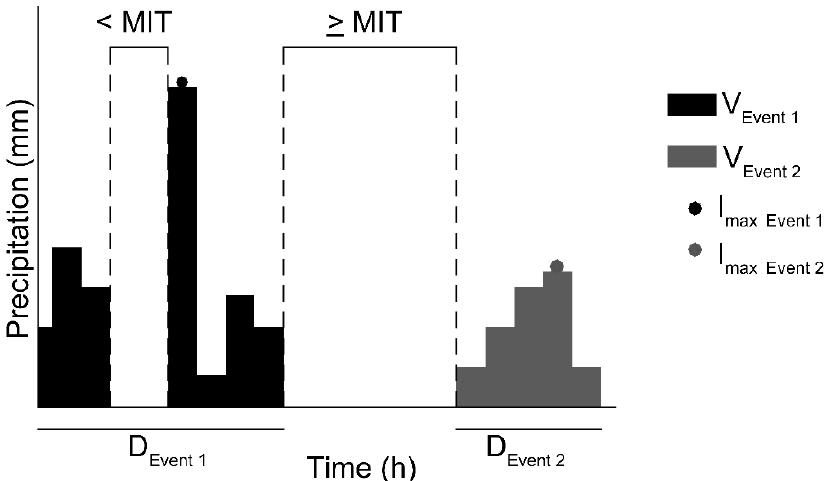
Figure 2. Example of two independent rainfall events (black and grey for events one and two, respectively). The total depth of the event (V Event ) is represented by the shaded area, the maximum intensity (I max ) is represented by the dots, and the duration (D Event ) by the lower line. Two dry periods are represented in the figure. The first one, has a shorter duration than the minimum inter-event time (MIT) and therefore, the two wet periods belong to the same event. In the second dry period, the duration is longer than the MIT and it represents the separation between the two events.